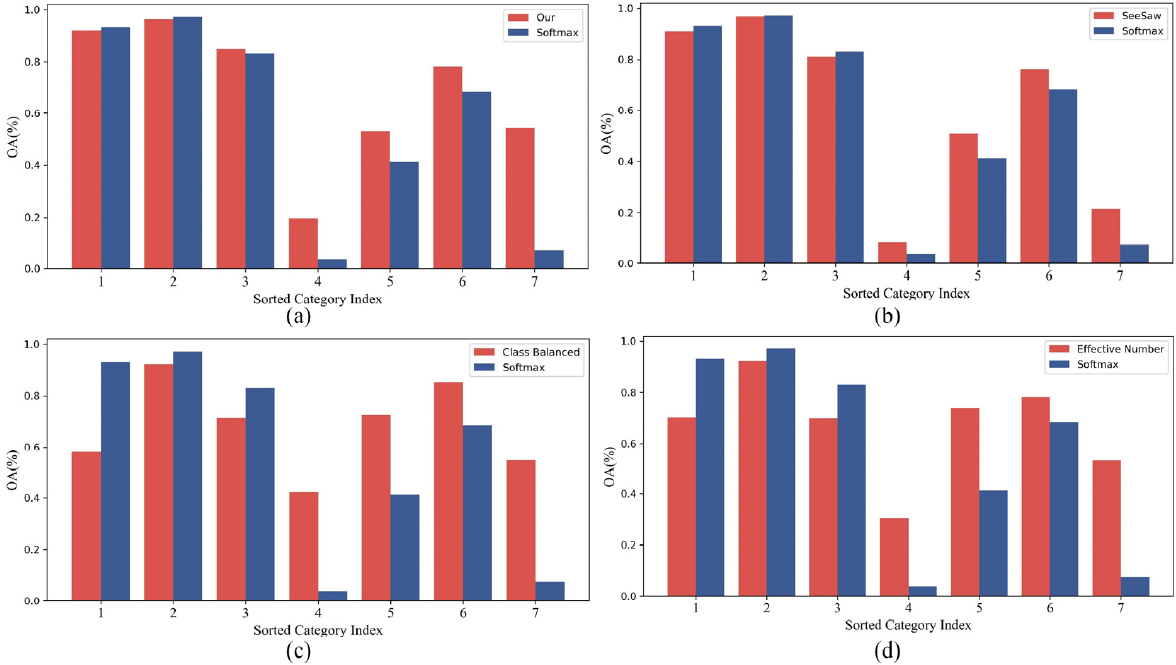
Figure 12. ( a – d ) show the classification accuracy of our proposed methods, SeeSaw, Class Balanced, Effective Number with Softmax cross-entropy for samples from each category on the long-tailed HistAerial dataset, respectively.